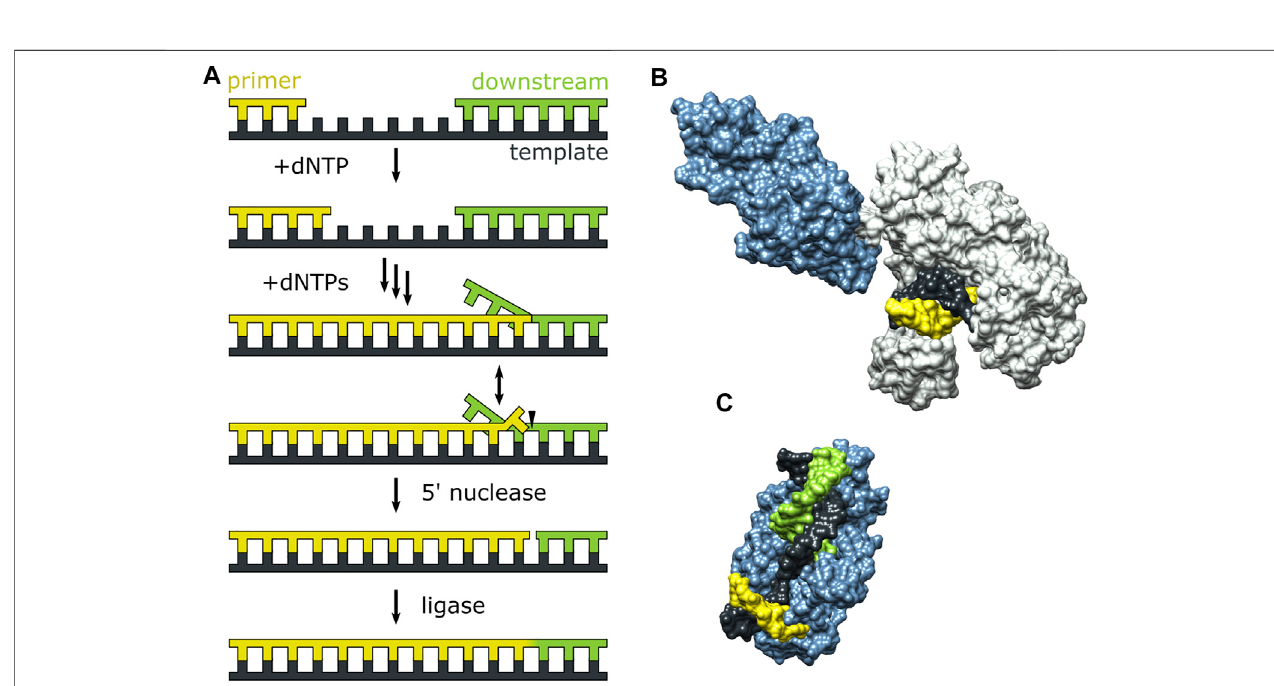
FIGURE 7 | Activities of Pol I and three-dimensional structures of Pol I homologs. (A) Processes catalyzed by Pol I during lagging strand DNA synthesis and base excisionrepair. (B) CrystalstructureofthePolIhomologTaqpolymerasewithprimer/templateDNAatthe pol site(PDBcode1TAU).Thepolymerasecoreisgreyandthe 5 ′ nuc domainisblue. (C) CrystalstructureofhumanFEN1(homologoustothe 5 ′ nuc domainofPolI)boundtoaDNAsubstrate(PDBcode3Q8M).In (B,C) ,theprimer, template and downstream strands are colored as in (A) . Reproduced from reference (Pauszek et al., 2021) with